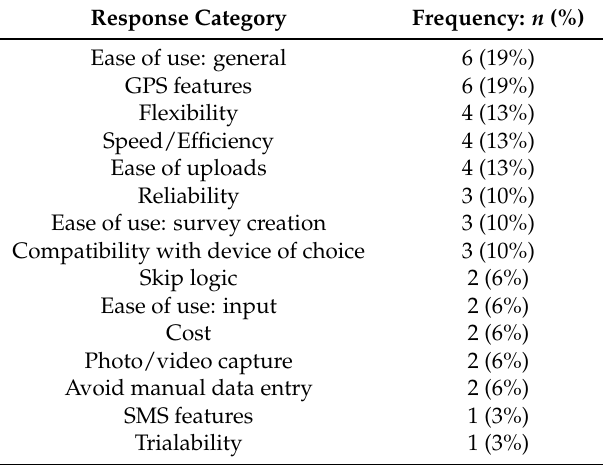
Table 7. Most beneficial MST